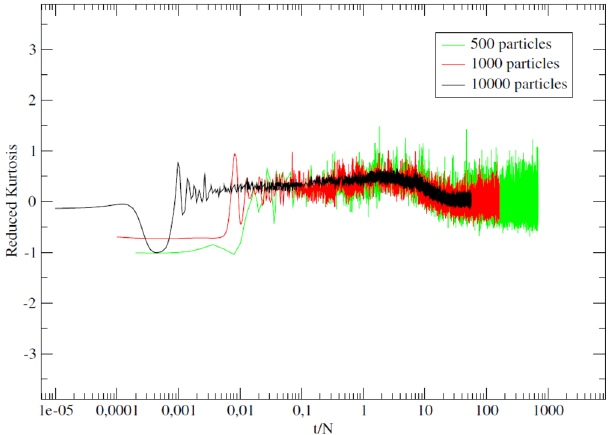
Figure 6. Reduced kurtosis for different system sizes with N = 500, 1000 and 10000 particles. The horizontal axis is the time t divided by N in logarithmic scale. We notice that, as the time increases, k approaches and eventually fluctuates about 0. Fluctuations are reduced for larger N values. In the t / N reduced variable, the three curves go to zero simultaneously signaling that the time to reach the thermal equilibrium diverges like N .